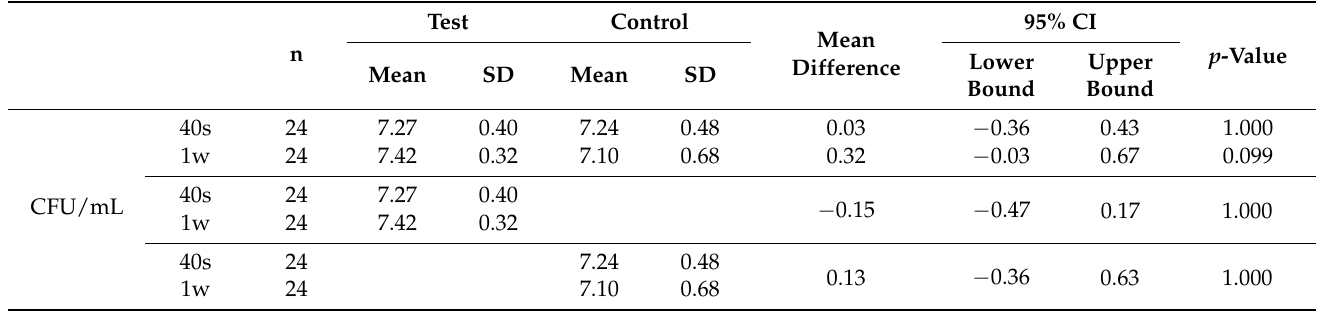
Table 5. Log 10 of colony forming units (CFU) per millilitre and per square millimetre of the toothbrush